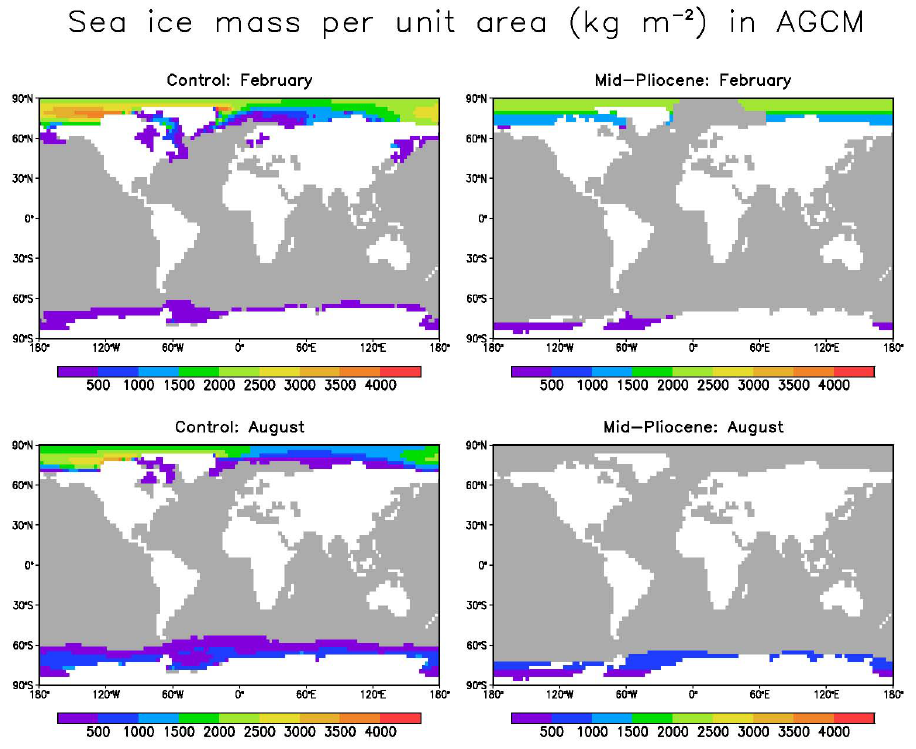
Fig. 5. Sea ice mass per unit area imposed on the AGCM during February and August for the control experiment (left side) and for the mid-Pliocene experiment (right side).